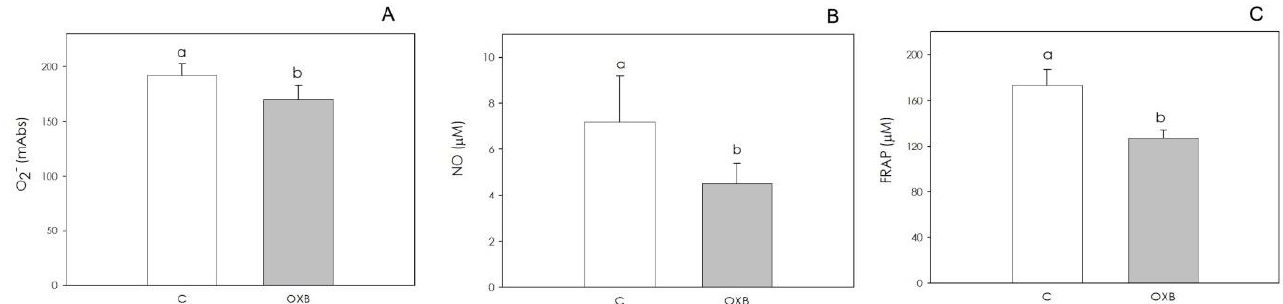
Figure 7. Effect of the 48 h treatment with orexin B (OXB; 10 nM) on swine aortic endothelial cells’ superoxide anion generation (O 2 − ) using WST assay ( A ), nitric oxide (NO) production using Griess assay ( B ) and non-enzymatic scavenging activity using FRAP assay ( C ). Data, expressed as milliAbsorbance (mAbs), represent the mean ± SEM of six replicates/treatment repeated in five different experiments. In each panel, different letters on the bars indicate a significant difference ( p < 0.05) among treatments as calculated by ANOVA and Scheff è ’s F